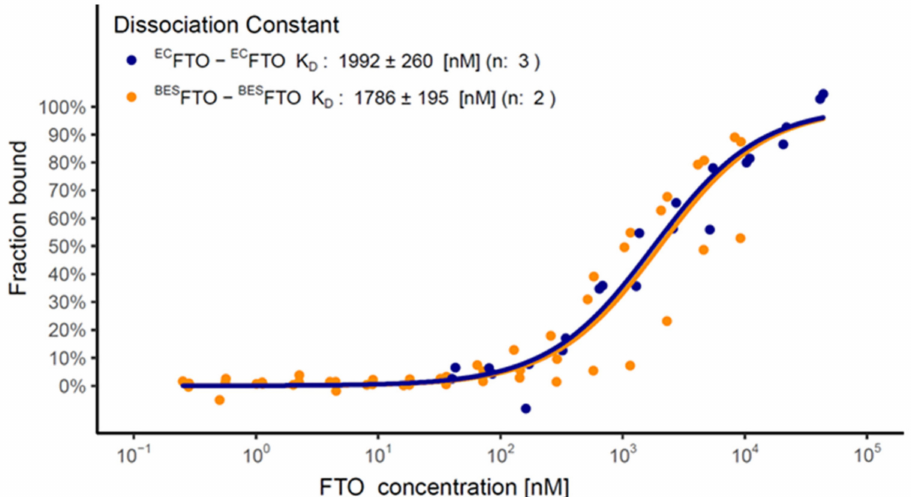
Figure 9. MST analysis of EC FTO (blue) and BES FTO (orange) dimerization in the presence of Fe 2+ and 2-OG. The difference between the K D values for EC FTO and BES FTO is not statistically significant. The plot represents the dimer level of the labeled protein at a given FTO concentration for each separate sample (data points) and for modeled equilibrium between monomer and dimer (straight lines). K D are shown as estimated value ± standard deviation. n—number of